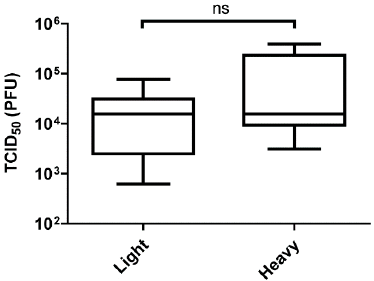
Figure 4. Virus yield of injected SINV in whole mosquitoes. Five to seven-day old female mosquitoes were injected with 5 × 10 5 particles of MRE3’2J-GFP. The mosquitoes were then snap frozen 2 days post-injection and then homogenized. The homogenate was then serially diluted and added to Vero cells to determine TCID 50 . All error bars represent standard error of mean (SEM).